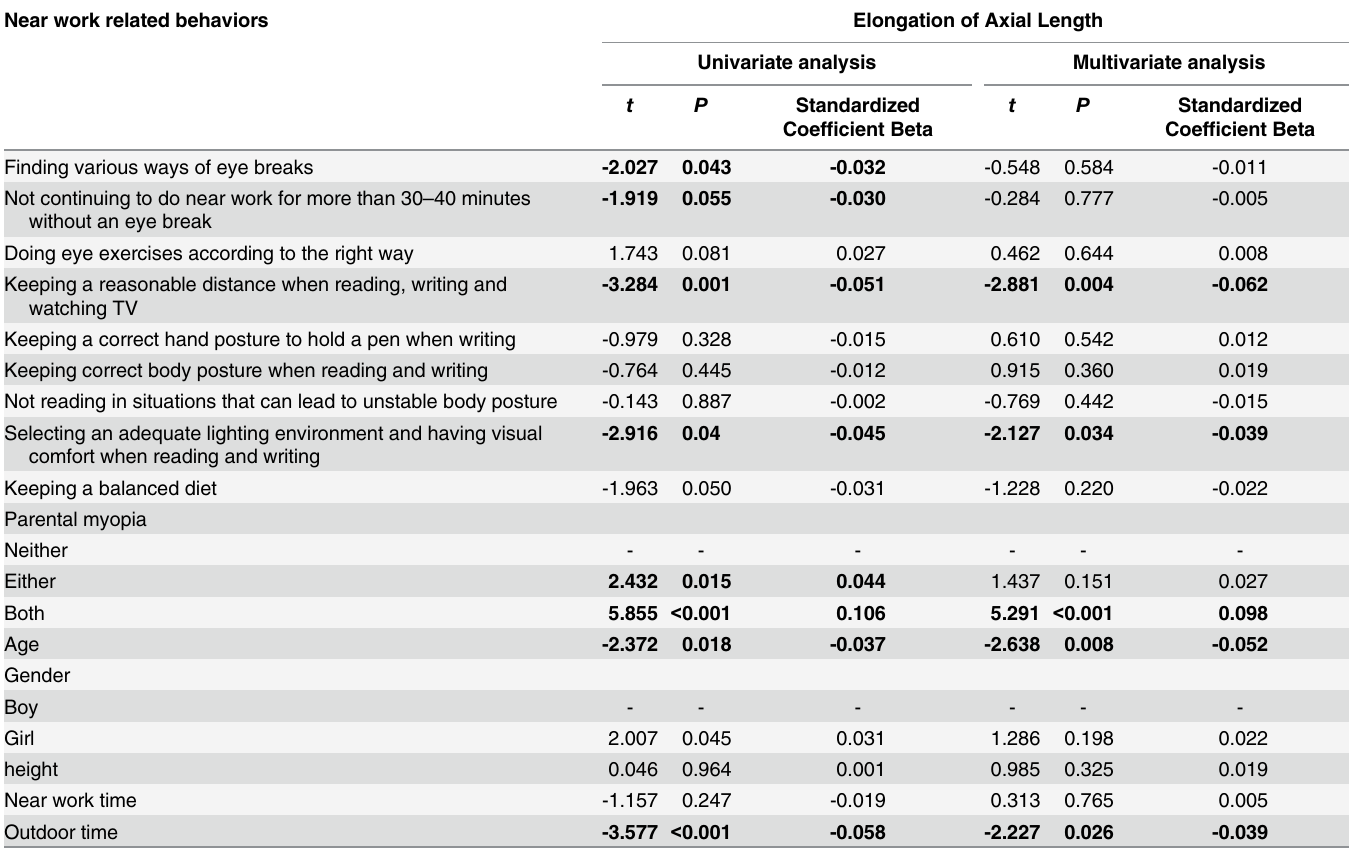
Table 3. Near work related behaviors associated with elongation of axial length within one year in students of grade 1 to 4 in